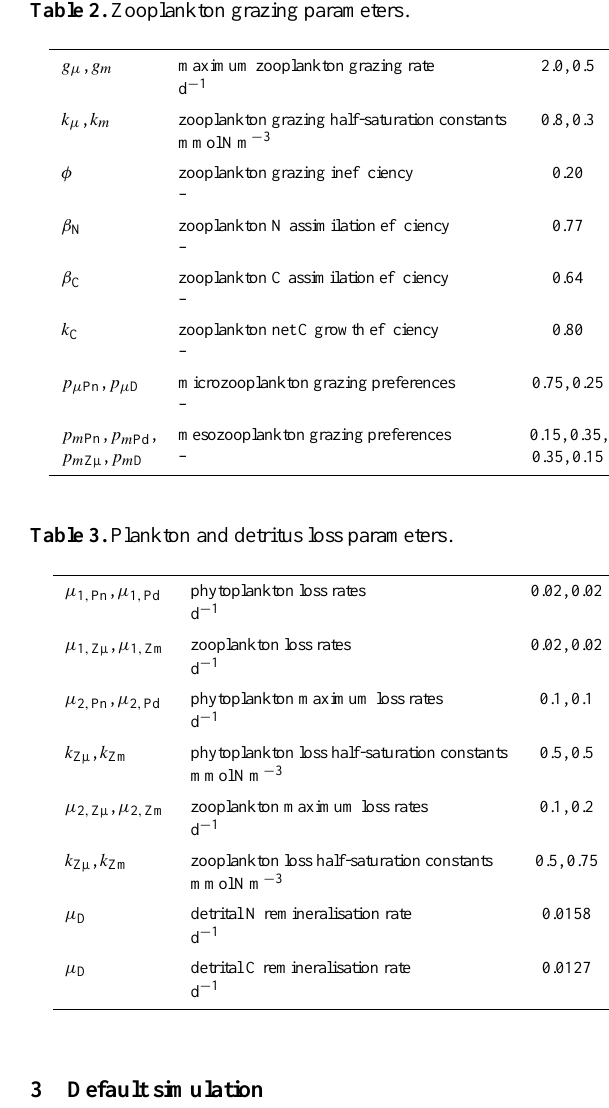
Table 1. Phytoplankton growth parameters. Table 2. Zooplankton grazing parameters.